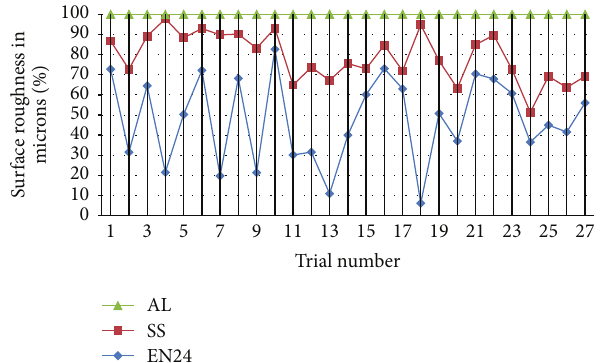
Figure 3: Comparison percentile graph (taking highest as 100%) for surface roughness variation of ductile materials.